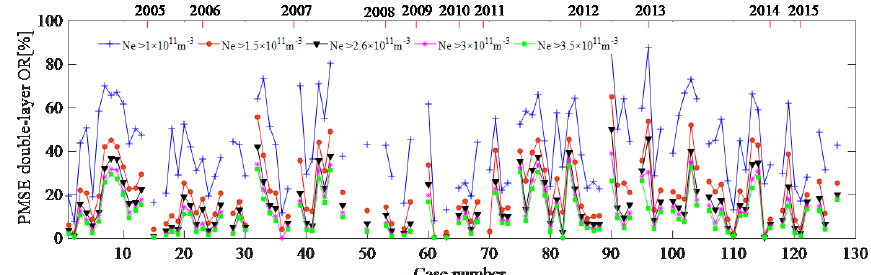
Figure 6. PMSE double-layer occurrence ratio under different electron density thresholds, with the axis at the top showing the time in years.